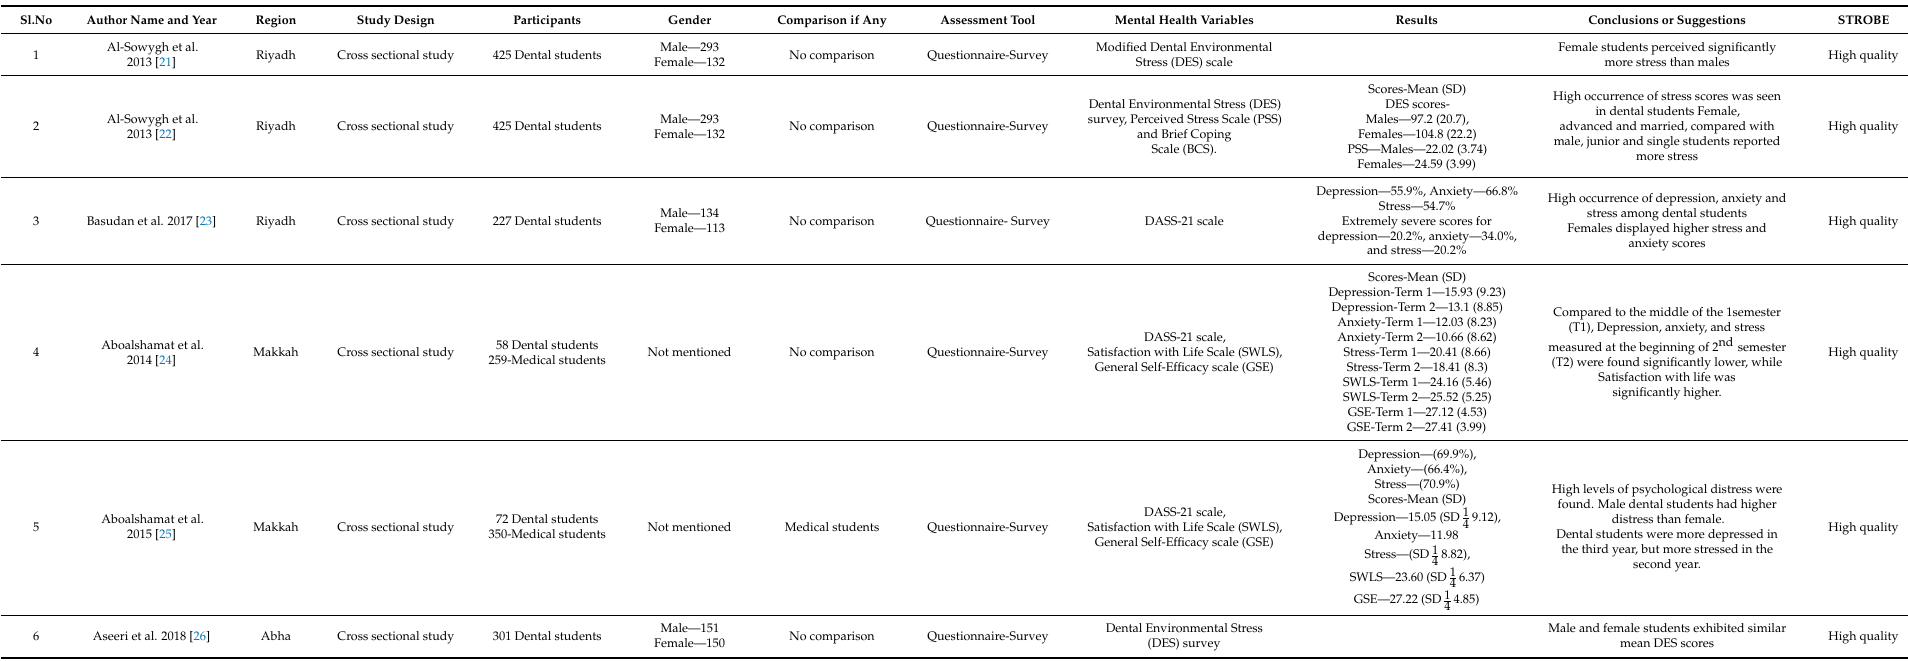
Table 1. The characteristics of studies that were included in this systematic